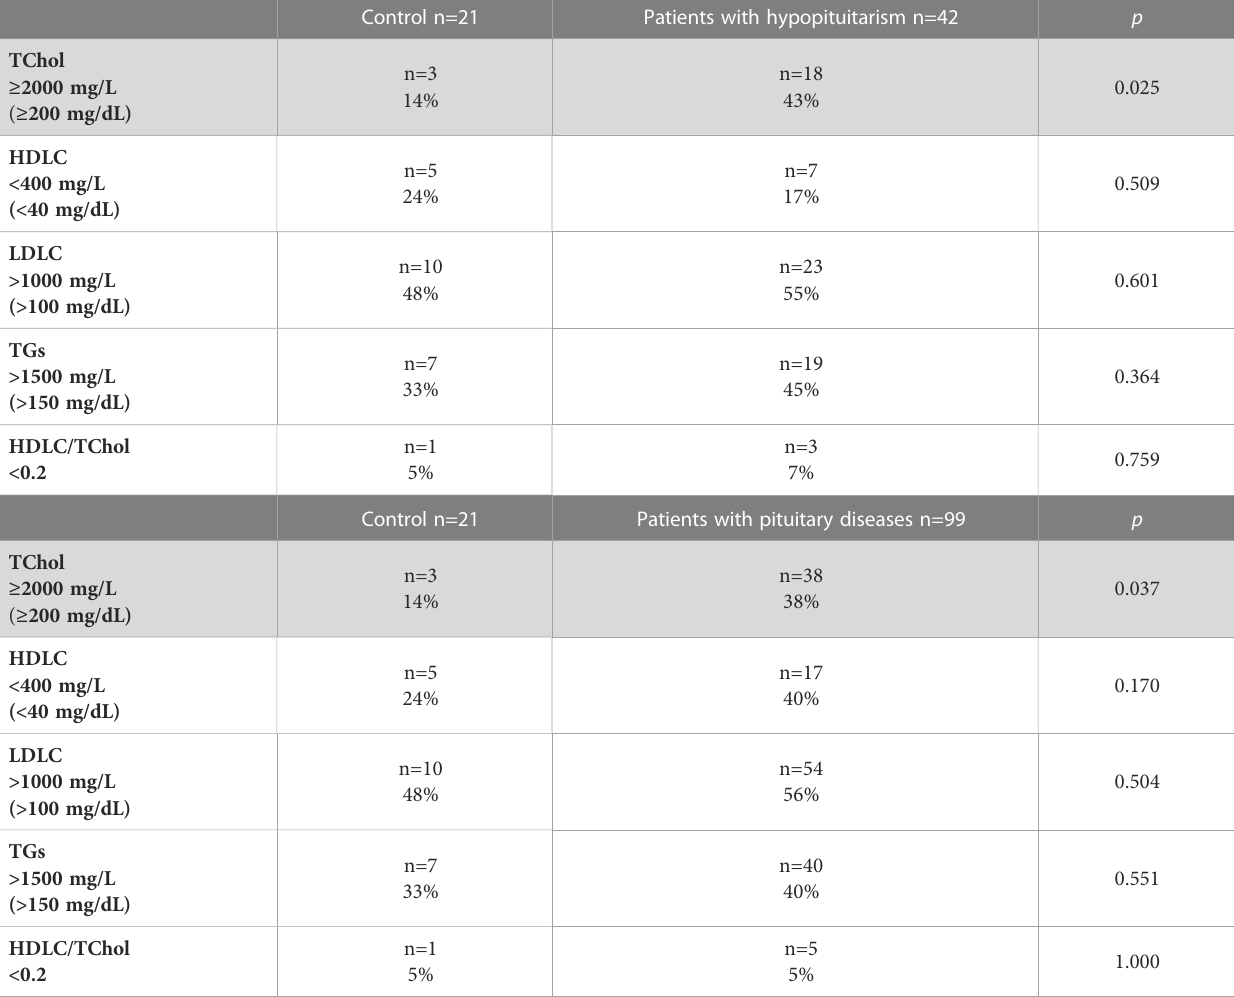
TABLE 4 Percentage of abnormal lipid pro fi le in control individuals (n=21) vs. patients with hypopituitarism (n=42) (above), and in control individuals (n=21) vs. patients with pituitary diseases (n=99)